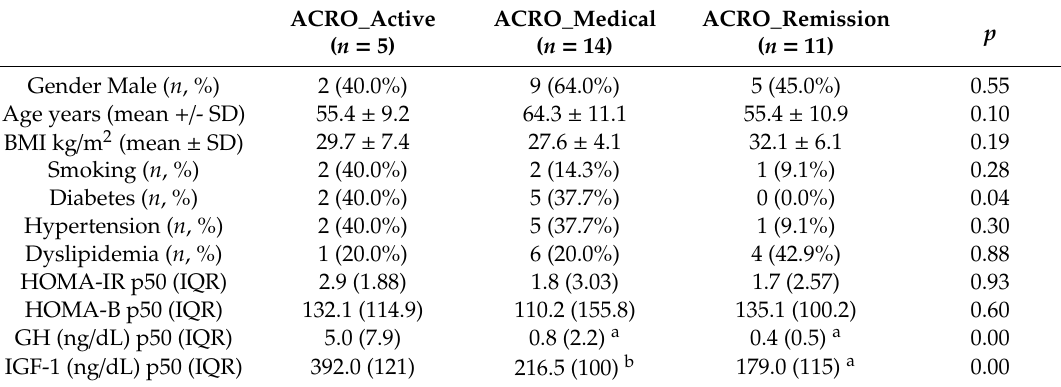
Table 2. Basal characteristic of patients according to disease